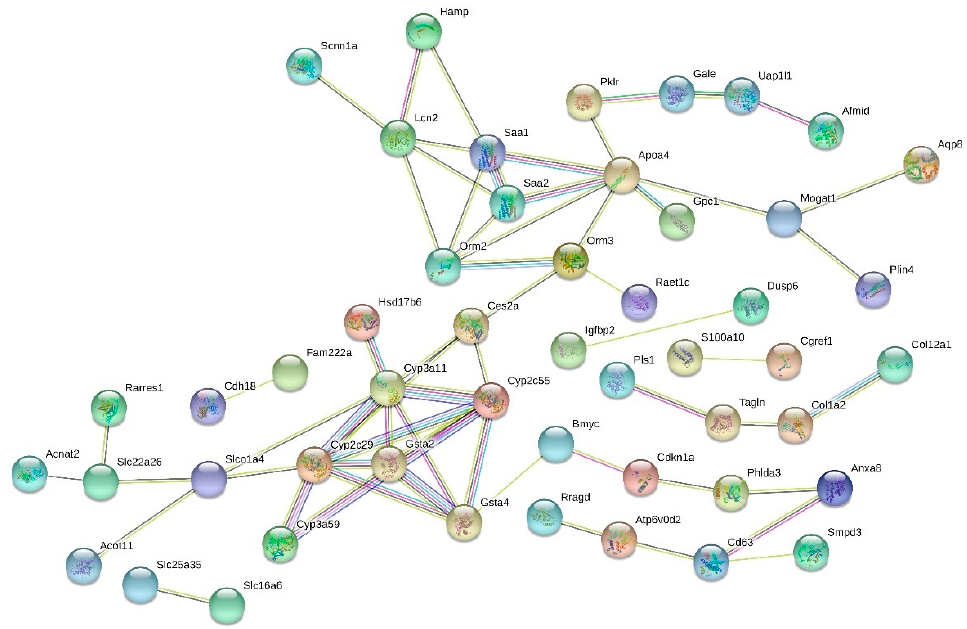
Figure 5. Interactions among the genes with greatest expression fold change in HF + LGB vs. HF groups. Genes with expression fold change (FC) > 1.5 or < − 1.5 in high-fat diet supplemented with lingonberry (HF + LGB) vs. high-fat (HF) diet groups were studied with STRING. Genes with no identified interactions were excluded from the graph. Colors of the edges: green = activation, blue = binding, black = chemical reaction, red = inhibition, violet = catalysis, pink = posttranslational modification, yellow = transcriptional regulation, grey = other interaction.